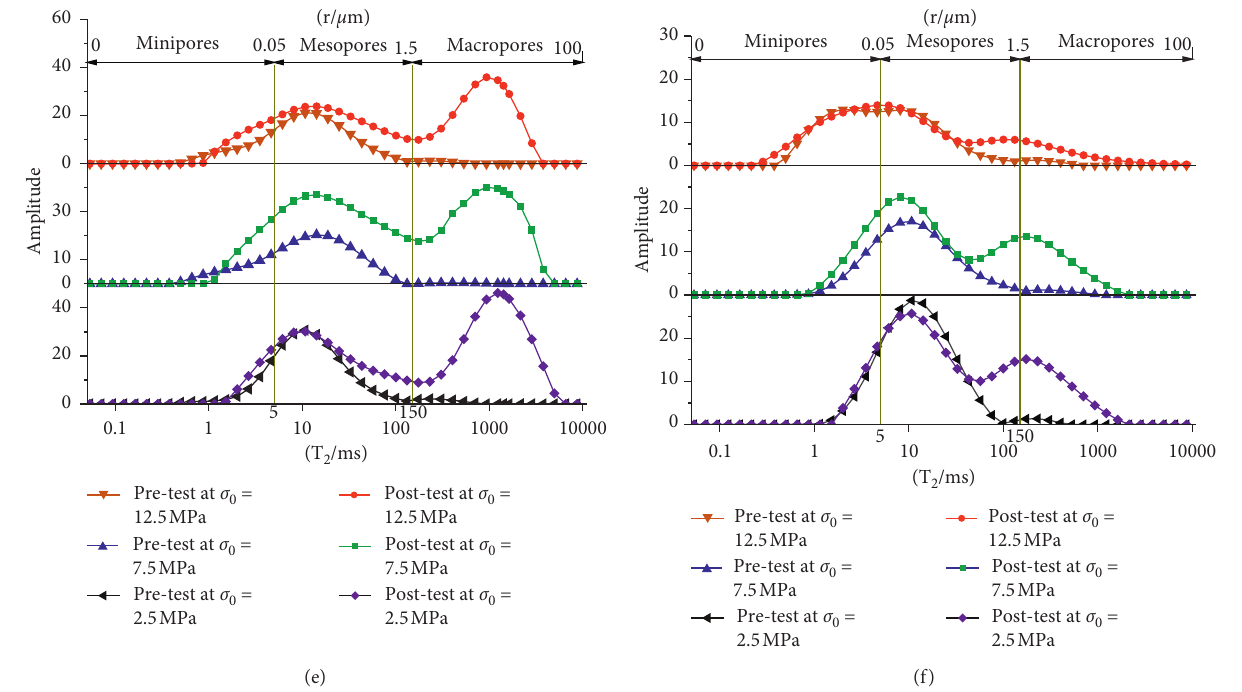
Figure 4: T 2 spectrum distributions for different loading rates and initial peak stresses before and after the test: (a) σ 0 (b) σ 0 � 2.5MPa, RIA cycling; (c) σ 0 � 2.5 MPa, DIA cycling; (d) v � 0.2mm/min, IA cycling; (e) v � 0.2mm/min, RIA cycling; and (f) v � 0.2mm/min, DIA